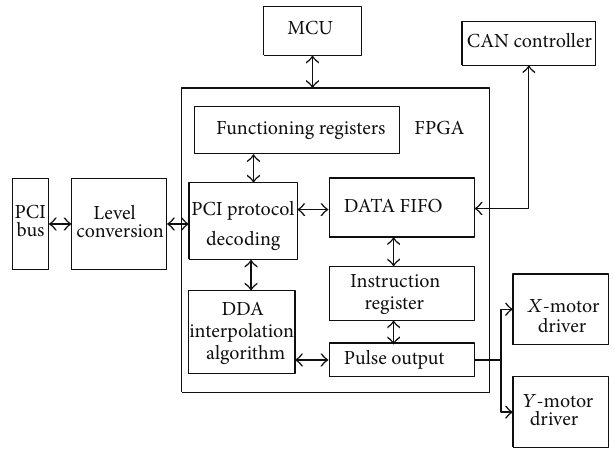
Figure 1: Systematic structure of the control